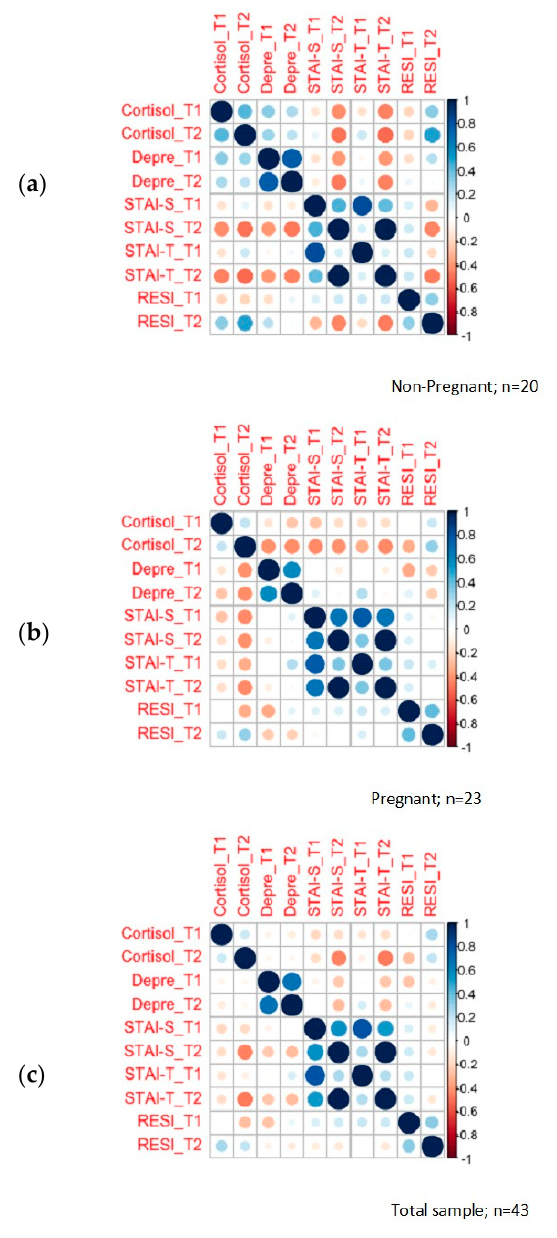
Figure 3. HCC and psychological symptoms correlation plot: ( a ) correlation between psychological symptoms and HCC in non-pregnant women; ( b ) correlation between psychological symptoms and HCC in pregnant women; ( c ) correlation between psychological symptoms and HCC in the total